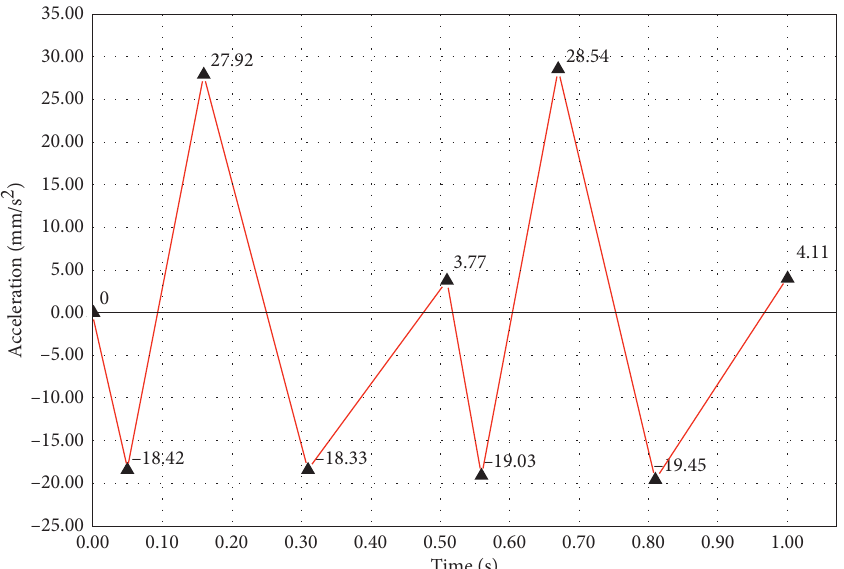
Figure 37: Measured ground acceleration at the pit